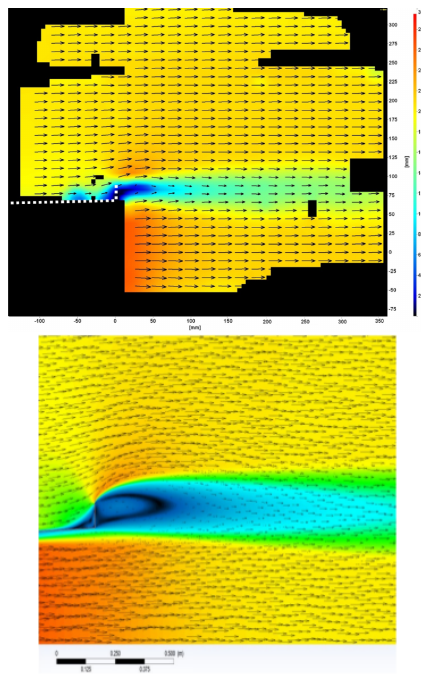
Figure 6: Velocity contour plot and vectors: PIV (L) versus simulation (R)